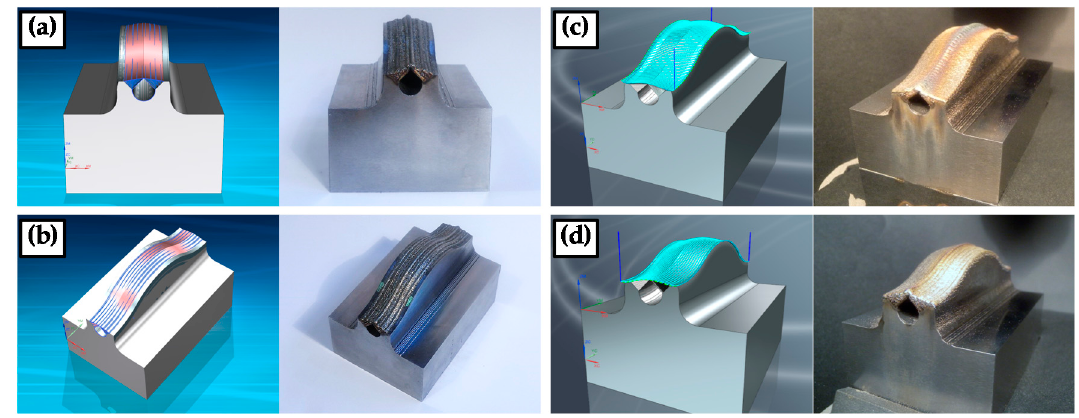
Figure 15. ( a ) Front; ( b ) lateral views of the resulting part after LMD; ( c ) transversal LMD; ( d ) longitudinal LMD.